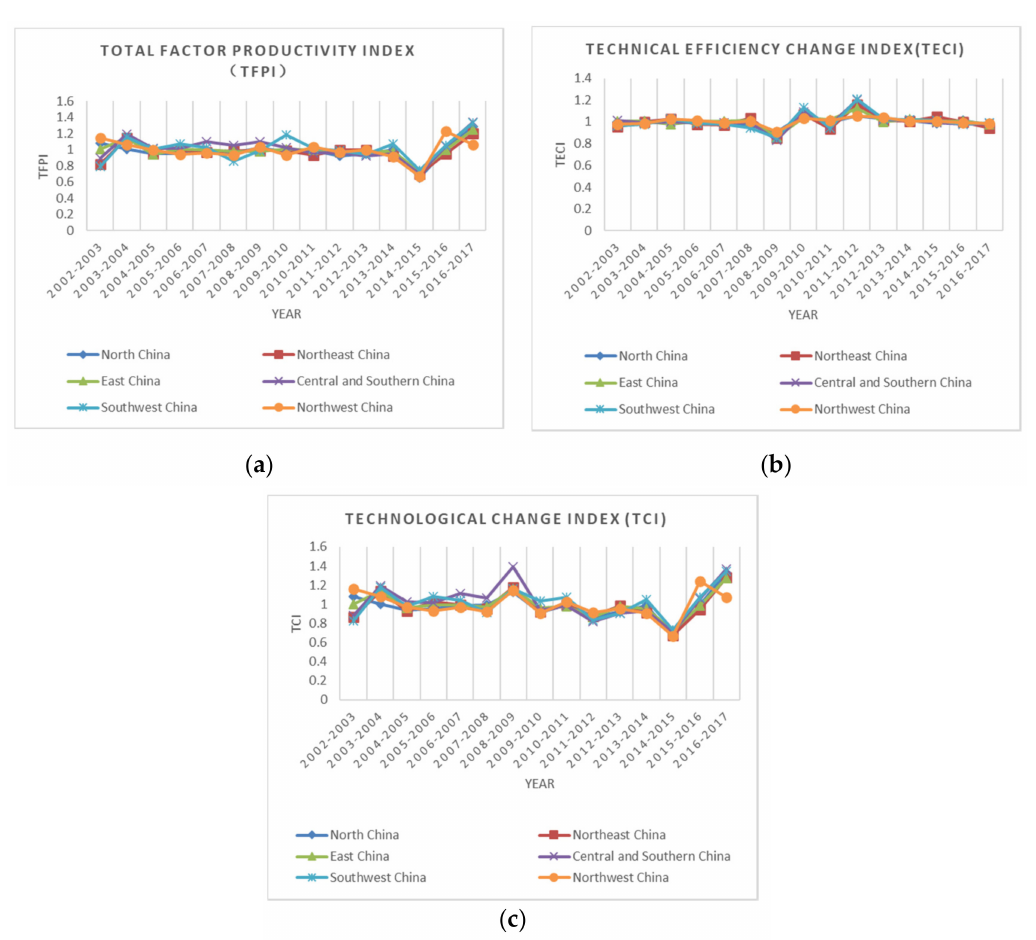
Figure 7. Six regions’ average TFPI, TECI, and TCI over the study period (bootstrap adjusted).